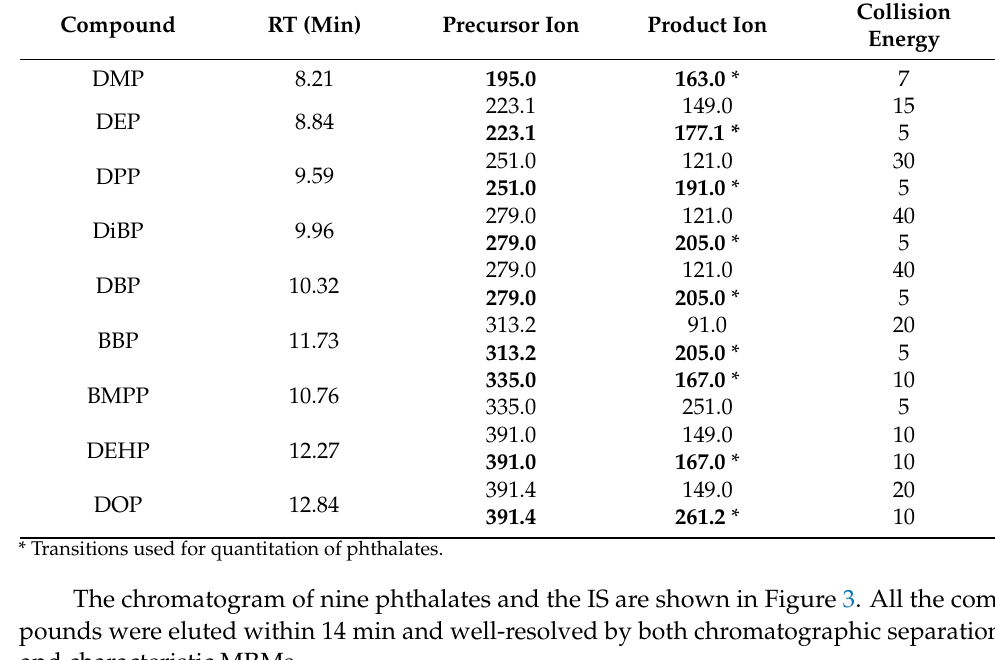
Table 1. MS conditions for analysis of nine phthalates.